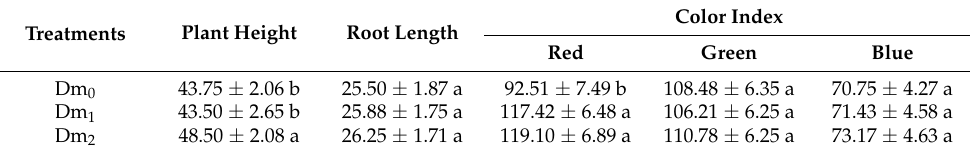
Table 2. The effects of different fertigation treatments (Dm 0 —standard nutrient solution, Dm 1 —raw leachate treatment, and Dm 2 —raw leachate blended with H 2 O 2 treatment) on plant height and root length (expressed in cm) and color index (RGB) in D. marginata plants at the end of the experiment. The results are expressed as means ± standard deviation ( n = 4). In each column, the same letters indicate non-significant differences ( p <